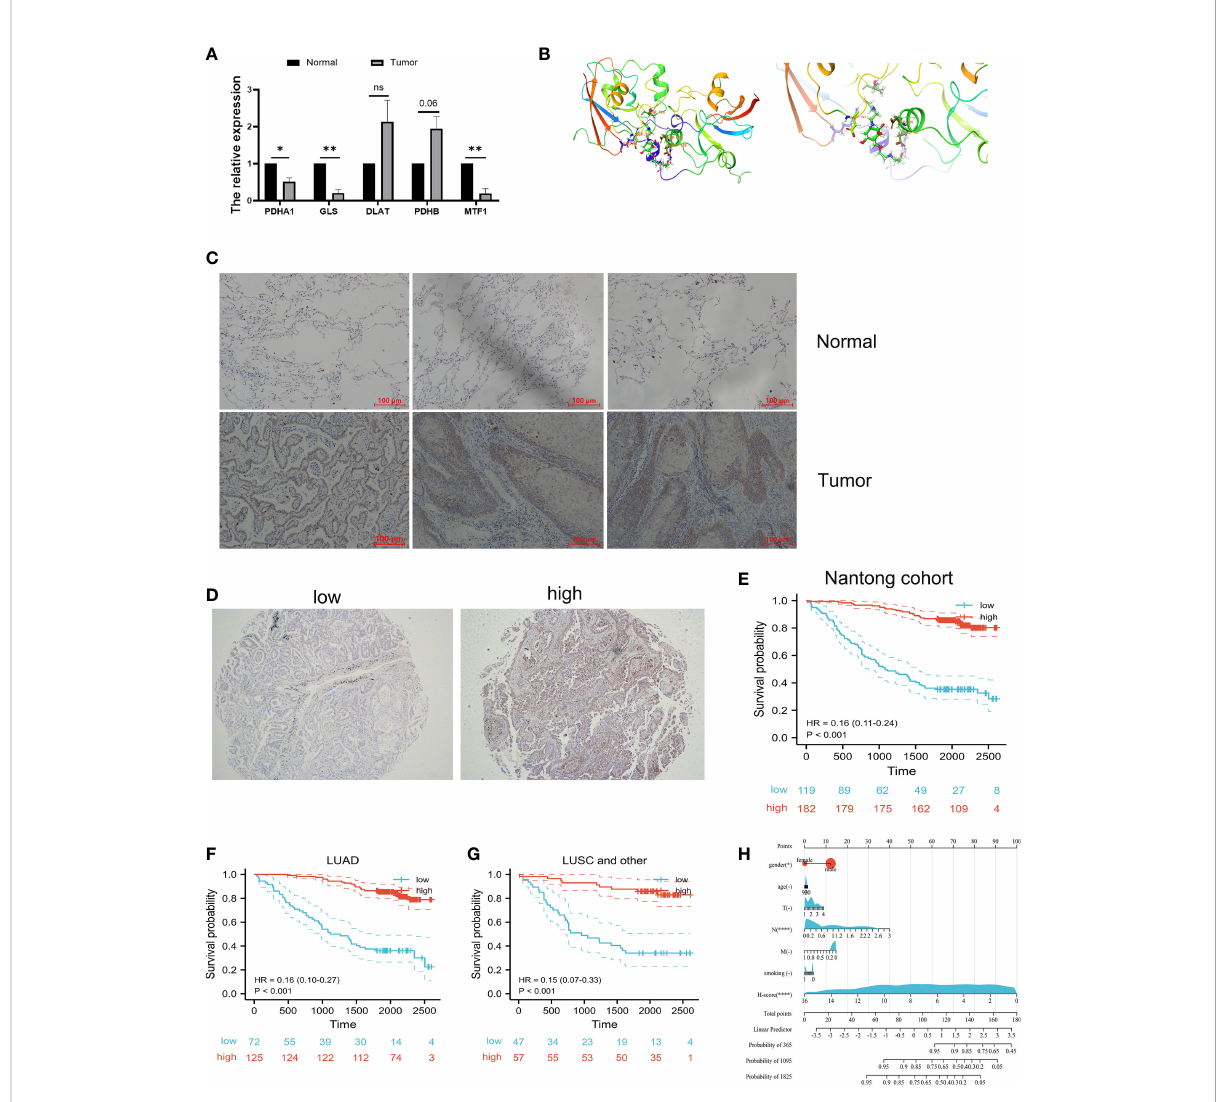
FIGURE 11 Validation of vitro experiment and molecular docking. (A) Validation of mRNA expression in prognostic cuproptosis-related signature by qRT- PCR. * P <0.05, ** P <0.01. (B) The molecular docking between FDX1 and mitoxantrone. (C) The IHC results showed that FDX1 protein is highly expressed in tumor tissues when compared with normal tissues. (D) Representative immunohistochemical microarray of FDX1. (E) Kaplan – Meier curves showed that the overall survival of the low-risk set was worse than that of the high-risk set in Nantong cohort. (F, G) Kaplan – Meier curves showed that the overall survival of the low-risk set was worse than that of the high-risk set in LUAD (F) and lung squamous cell (LUSC) subgroups (G) of patients. (H) The nomogram of the H-score and clinical parameters (age, gender, smoking and T, N, M stage) of Nantong cohort. ns, not signi fi